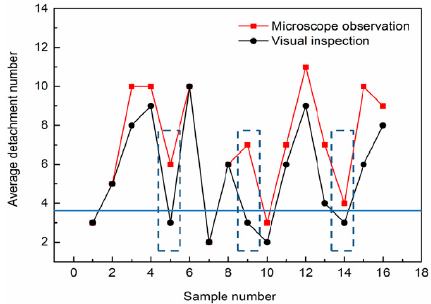
Figure 7. Difference in qualified and unqualified results for No. 5, 9, and 14 sample. Figure 7. Di ff erence in qualified and unqualified results for No. 5, 9, and 14 sample.